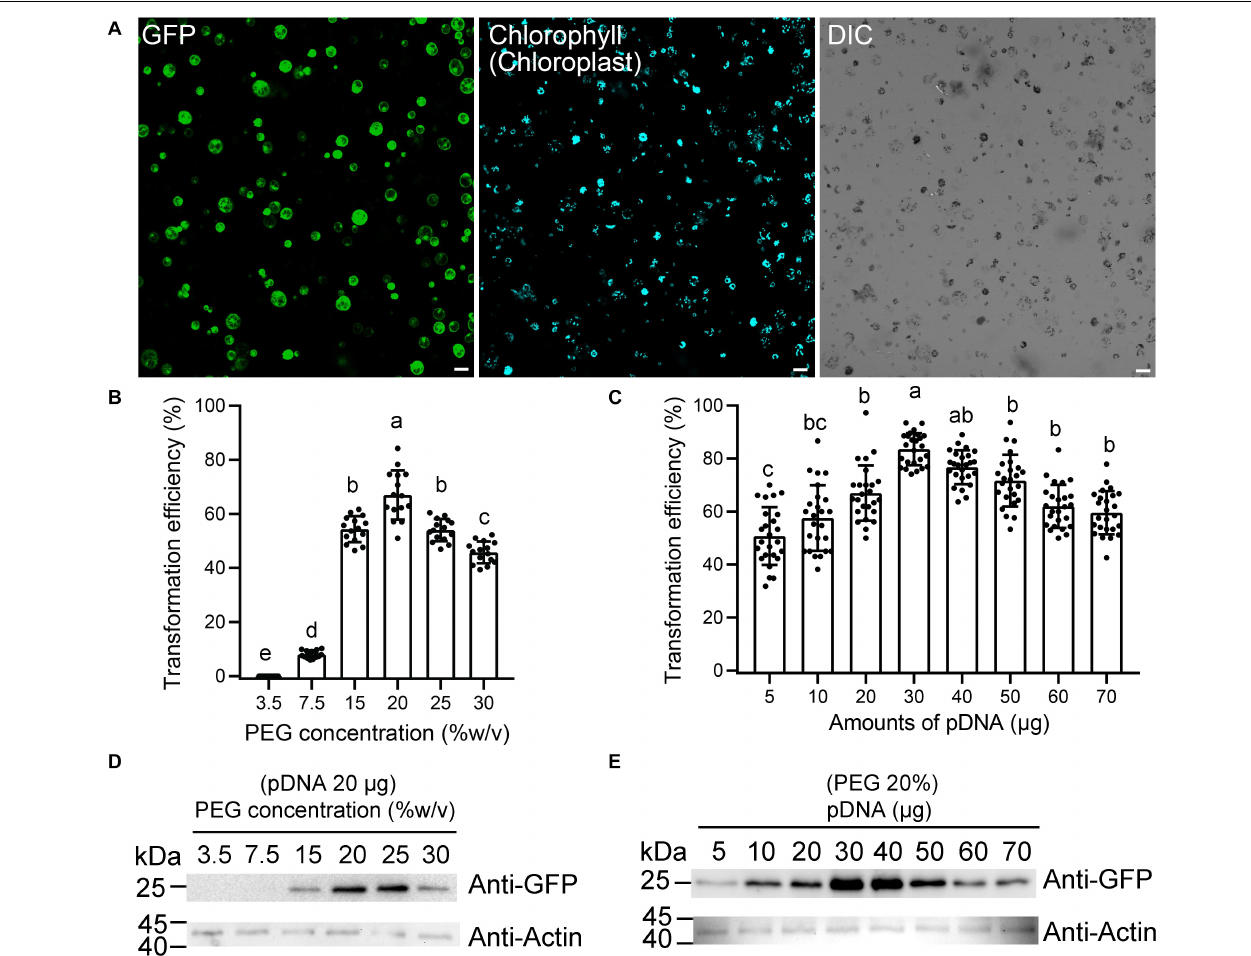
FIGURE 2 | Optimization of moso bamboo protoplast transient expression system. (A) Representative images of the type of data acquired for this assay (a), showing green fluorescent protein (GFP) (green) and chlorophyll autofluorescence (cyan). DIC, differential interference contrast. Scale bar = 50 µ m. (B–E) Assessment of protoplast transformation efficiency under varying final concentrations of polyethylene glycol (PEG) (B,D) or amounts of plasmid DNA (pDNA) (C,E) . The ratio of protoplast transformation (B) and Western blot (D) with constant amount of free GFP plasmids (20 µ g) at varying concentrations of PEG. The ratio of protoplast transformation (C) and Western blot (E) at varying amounts of free GFP plasmid DNA (pDNA) under constant final concentration of PEG (20%). Protein extracts were prepared from protoplasts after transformation and analyzed by Western blot using anti-GFP and anti-actin antibodies. Actin was used as protein loading control. The ratio of protoplast transformation was calculated from at least 15 confocal images with three biological replicates (protoplasts isolated from three independent batches). Values and error bars are mean ± standard deviation (SD). For the different treatments, lowercase letters represent significant differences between sample means ( p <